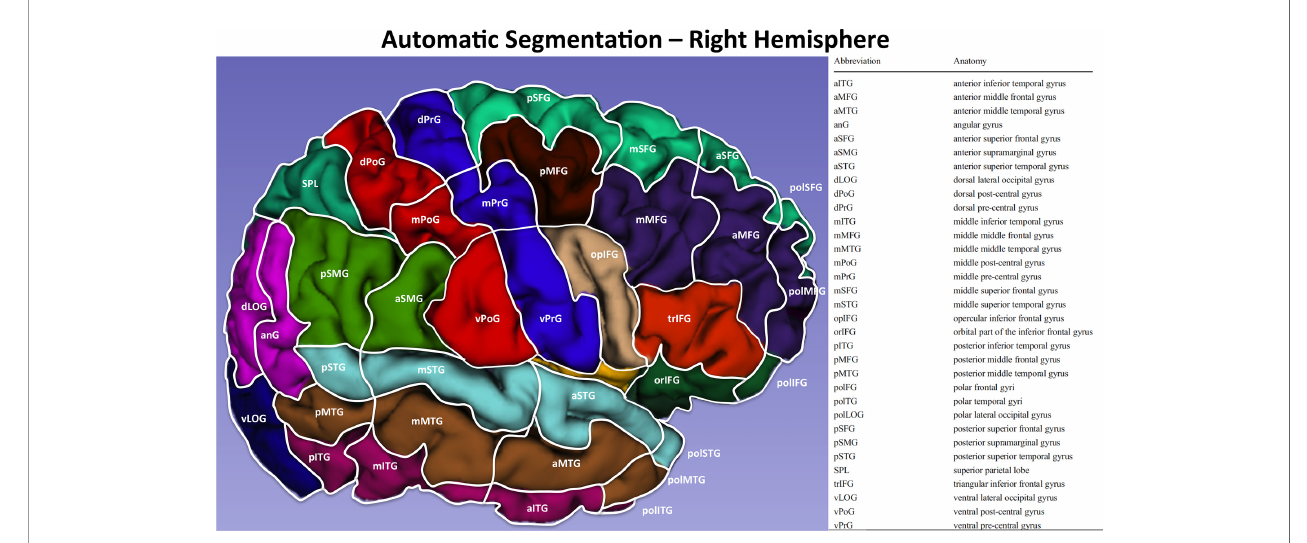
FIGURE 2 | Automatic segmentation of the cortical surface of the right hemisphere according to Corina et al (47). with the relative